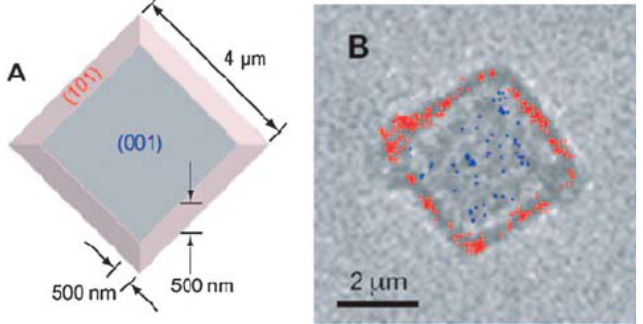
Figure 18. ( A ) Structure of anatase TiO crystal with preferential (001) facets; 2 ( B ) Transmission image of a single TiO crystal on the cover glass in Ar-saturated 2.0 μ M 2 3,4-dinitrophenyl-BODIPY solution under 488 nm laser and UV irradiation. The red and blue dots in image ( B ) indicate the fluorescence bursts located on the {101} and {001} surfaces, respectively, observed during 3 min irradiation. Reprinted from ref. [116] with permission of